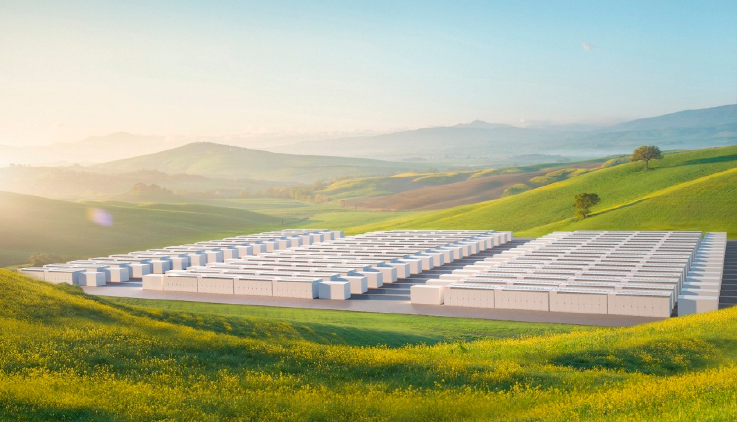
Figure 1. Tesla and Pacific Gas & Electricity Solar & Wind Energy Storage Megapacks at Monterey, California.